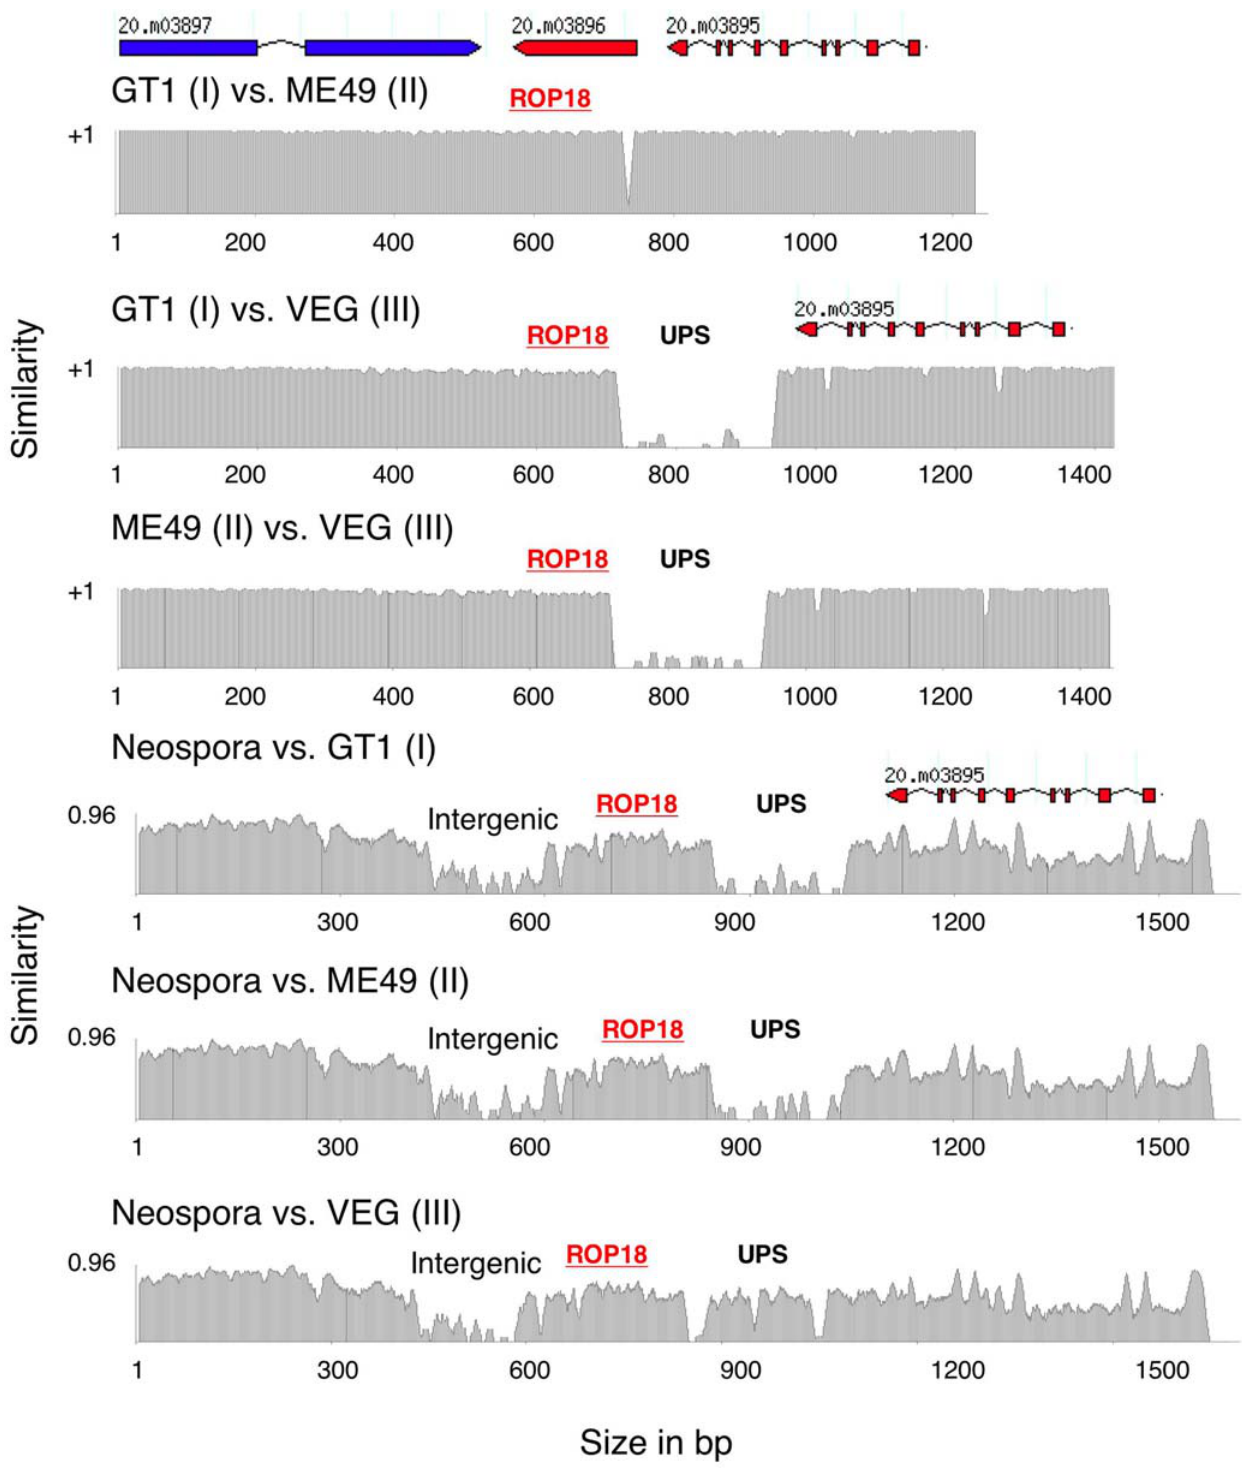
Figure 6. Evolutionary history of the upstream region in T. gondii compared to the out-group N. caninum . Pairwise sequence comparisons of genomic sequences between T. gondii strains and N. caninum showed the region surrounding ROP18 is highly syntenic with preservation of gene order and intergenic regions in N. caninum . The upstream region (UPS) of type III ROP18 (VEG) is found in N. caninum but is absent in type I (GT1) and type II (ME49), indicating that it was retained by type III* but lost in the ancestor to types I* and II*. The small region of dissimilarity between type I (GT1) and type II (ME49) corresponds to a slight difference in the rearrangements that presumably occurred in these lineages as shown in Figure 5A. X-axis is length in bp. Y-axis indicates the similarity values between two strains.